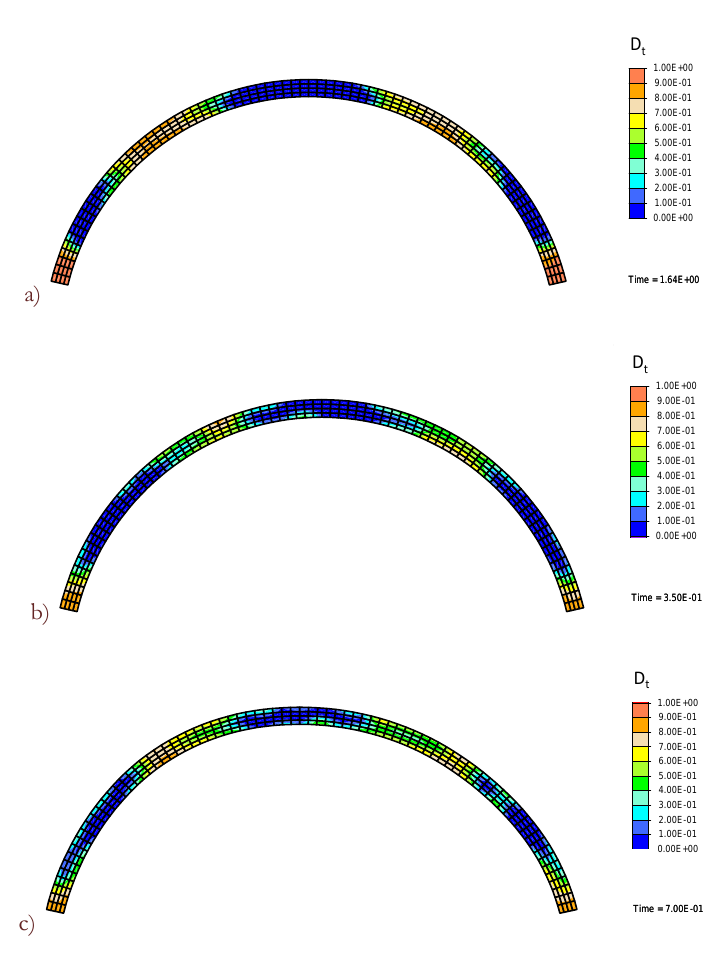
Figure 10: Damage